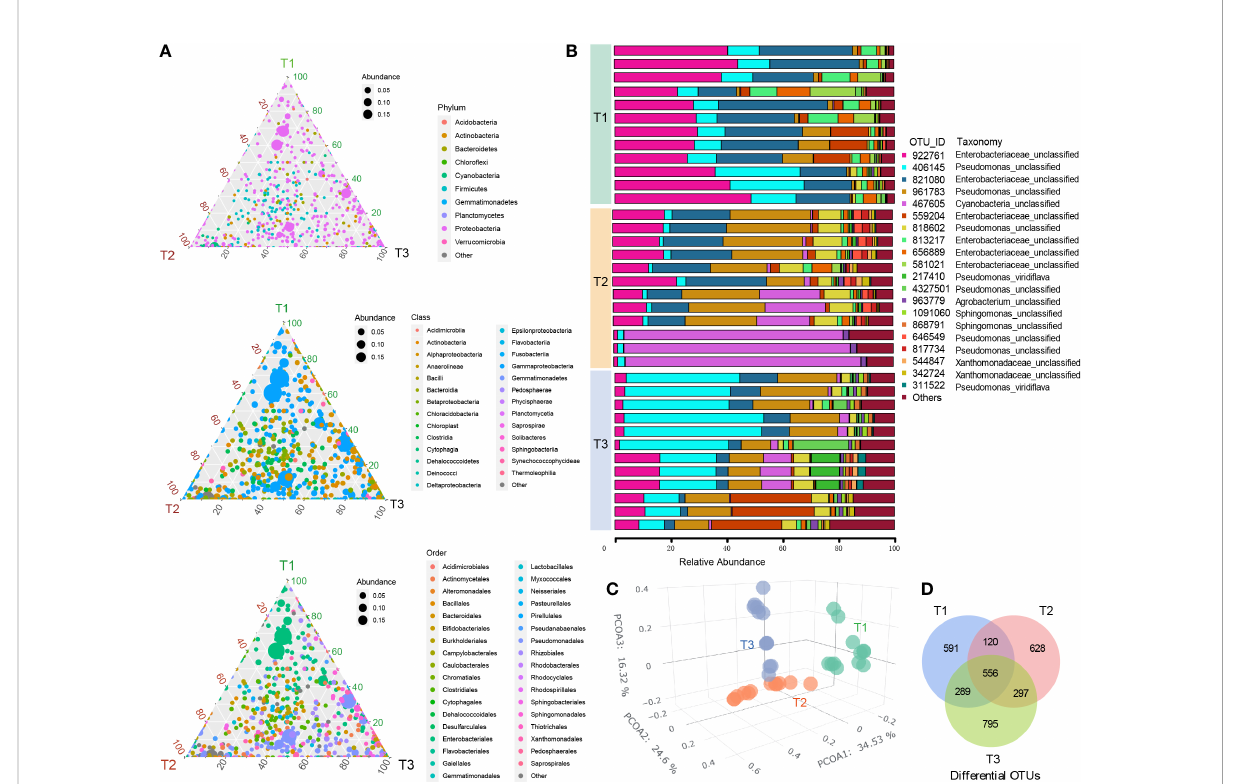
FIGURE 1 Bacterial community composition and diversity in tobacco phyllosphere. (A) The ternary phase diagrams showing the relative abundance and relationships of the different taxonomic categories (top, phylum; middle, class; bottom, order) in the three time series groups (three vertices, T1, T2 and T3). The size of each circle is proportional to relative abundance; the closer the circle is to the vertex, the higher the relative abundance of the group in that group. (B) Stack bar chart showing the twenty most abundant OUT taxa in each sample. (C) Principal coordinate analysis (PCoA) of Bray – Curtis dissimilarity matrices showing effects of time series (T1, T2 and T3 groups) on the tobacco phyllospheric bacterial community structure. (D) Venn diagram depicting number of shared or unique OTUs in each time series group (T1, T2 and